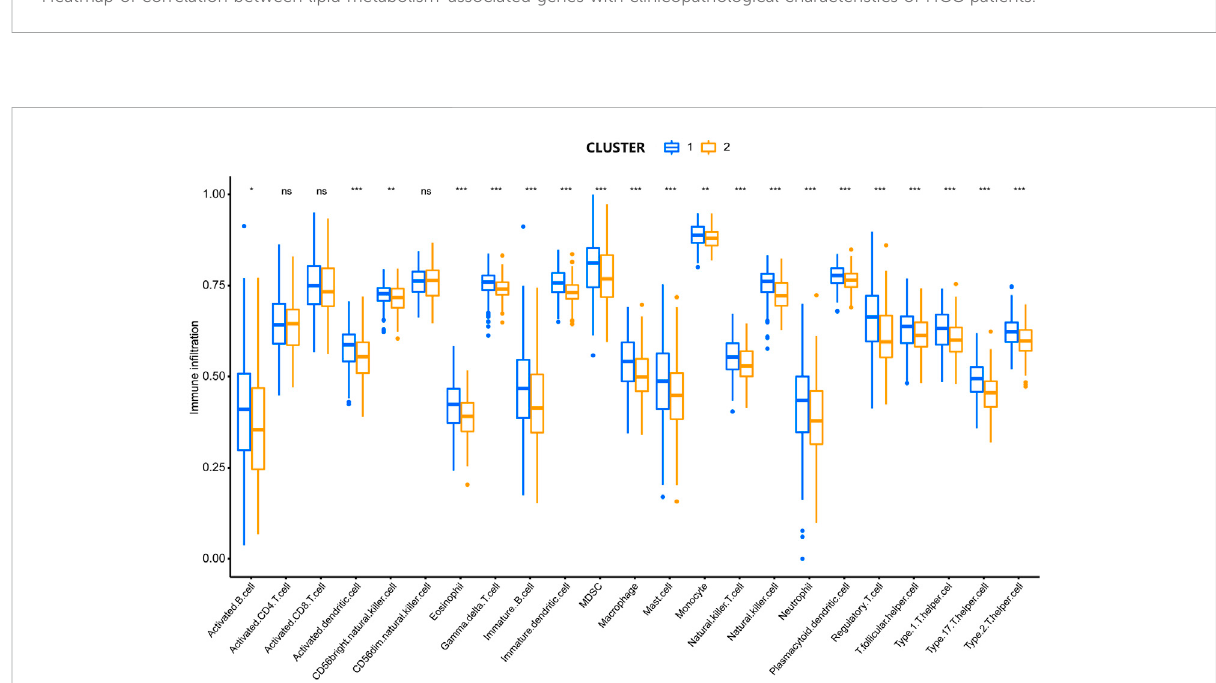
FIGURE 3 Comparison in the degree of immune cell in fi ltration between two clusters. *P < 0.05, **P < 0.01, ***P < 0.001.